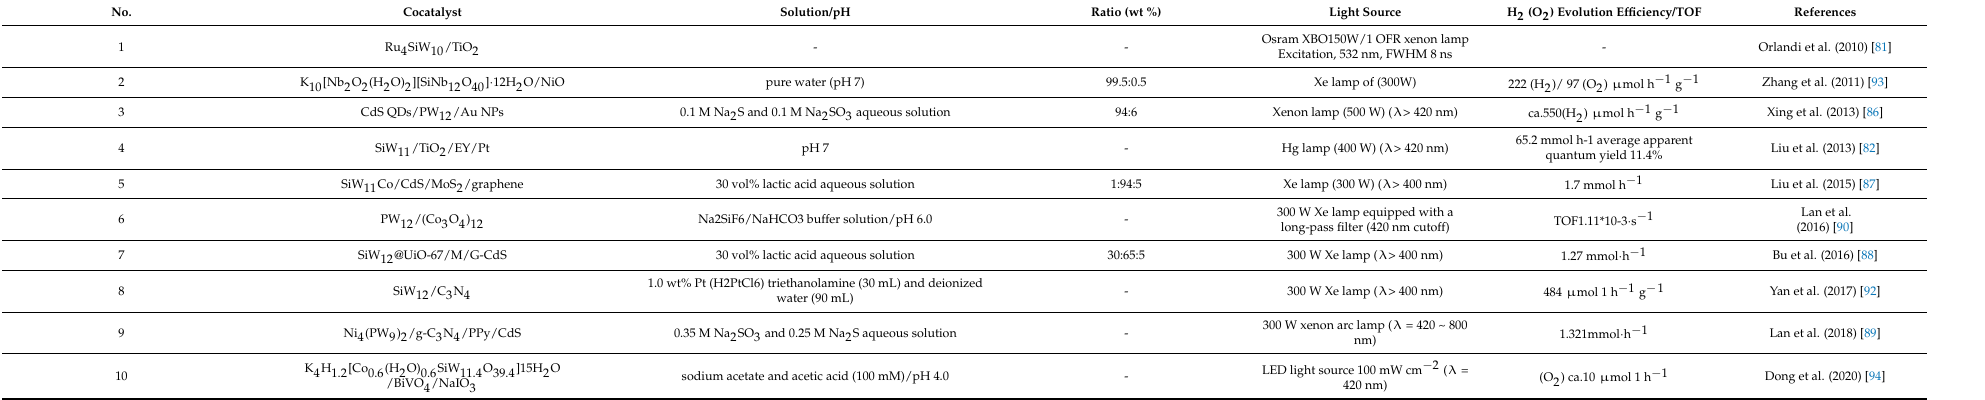
Table 1. Summary of POMs-based semiconductor compounds in photocatalytic water